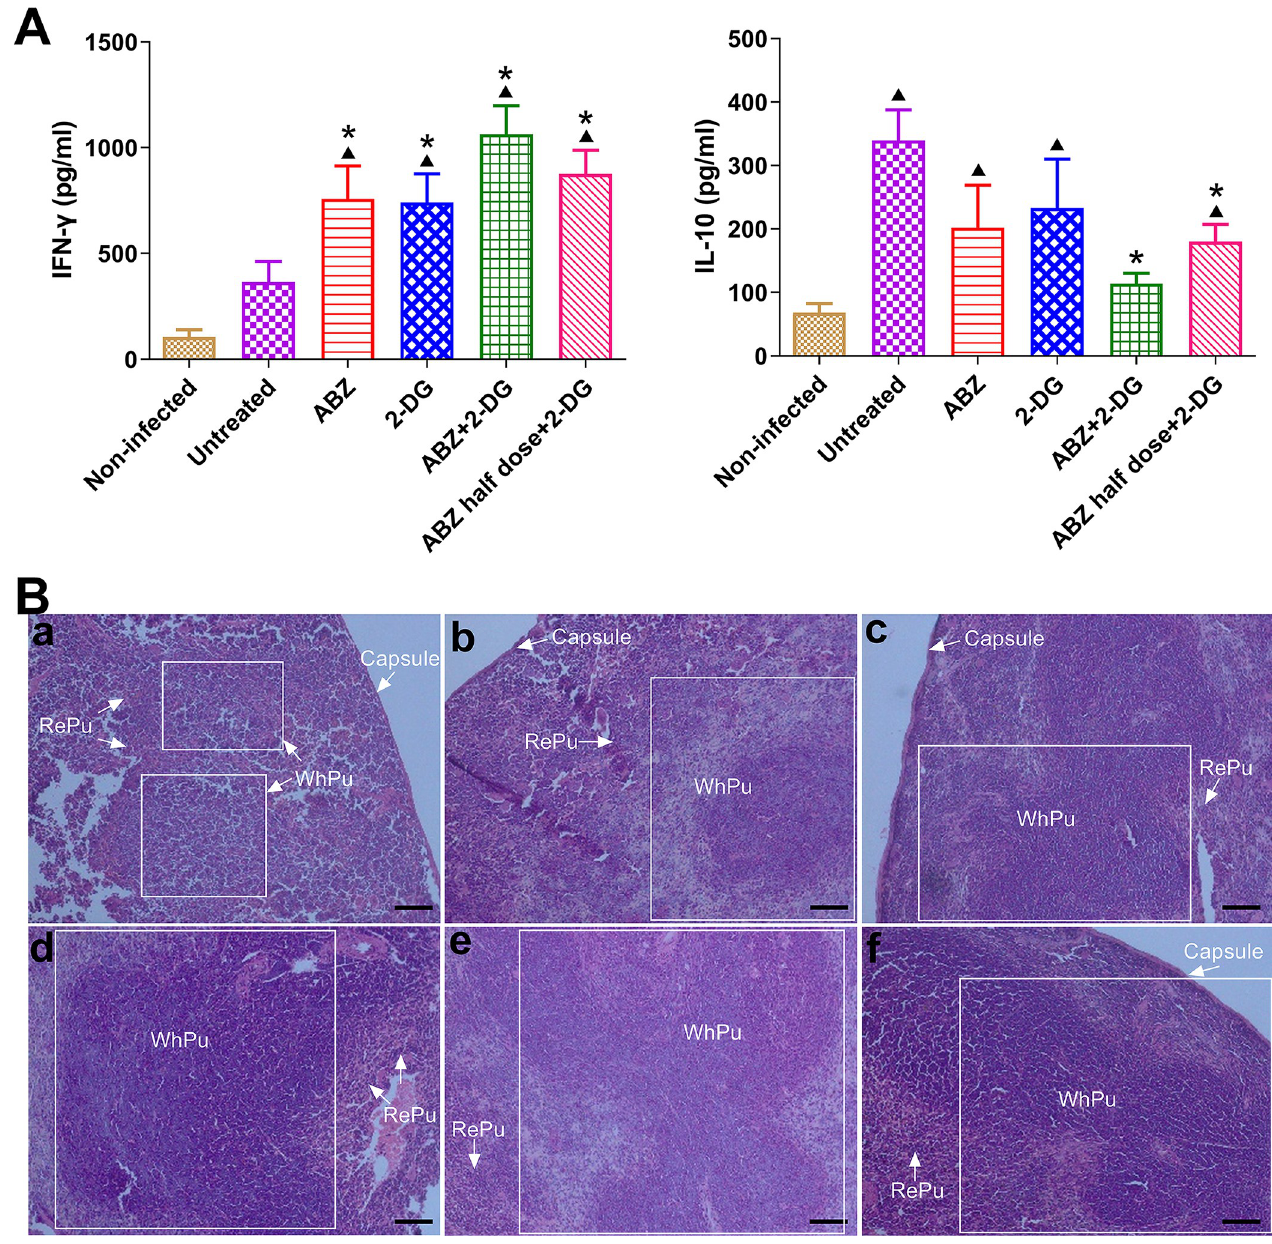
Fig 4. Cytokine profiles and histopathological examination. Serum concentrations of IFN- γ and IL-10 (A) were measured, and spleen tissues were observed (H&E staining) (B) from mice in different treatment groups. a, non-infected mice; b, mice infected with E . multilocularis metacestodes; c, d, e, and f, infected mice treated with ABZ, 2-DG, ABZ + 2-DG, and ABZ half-dose + 2-DG, respectively. RePu, the red pulp region in the spleen; WhPu, the white pulp region (lymphoid tissue containing lymphocyte production centers) in the spleen. � p < 0.05 vs. untreated mice, ▲ p < 0.05 vs. non-infected mice. Scale bar, 50 μ m.